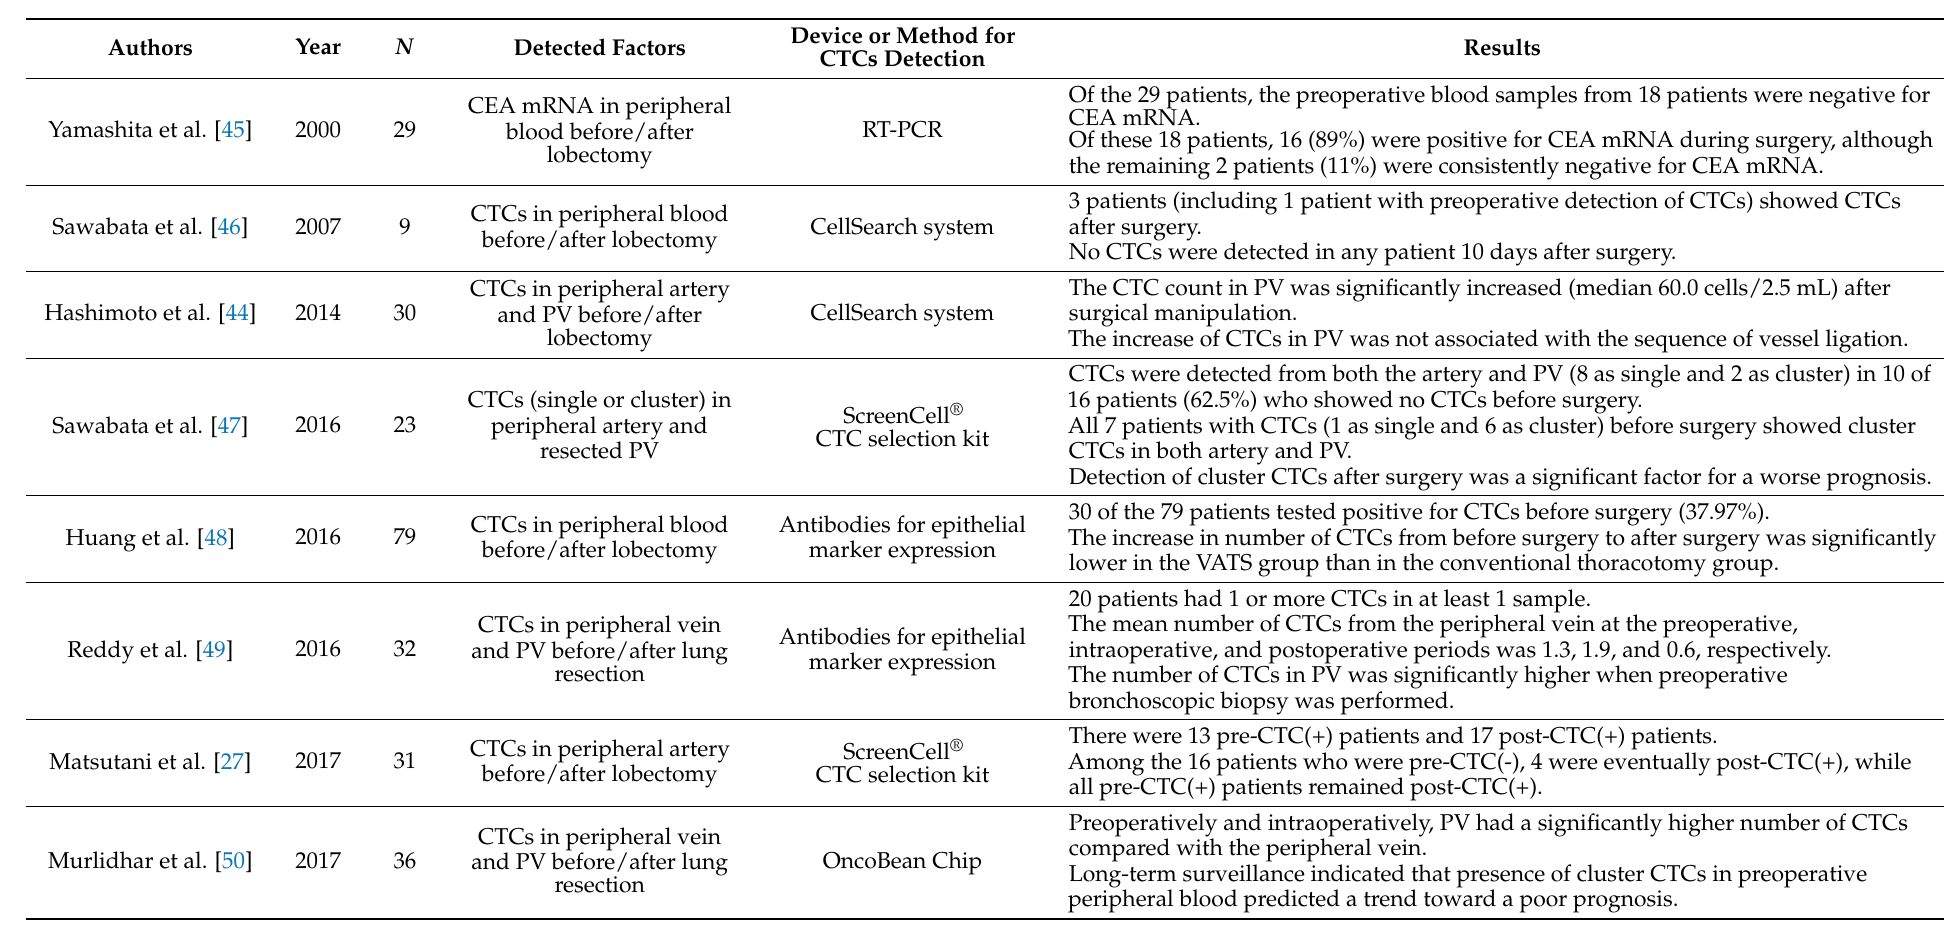
Table 1. Summary of studies researching the relationship between surgical manipulation and change in CTCs detection in non-small-cell lung